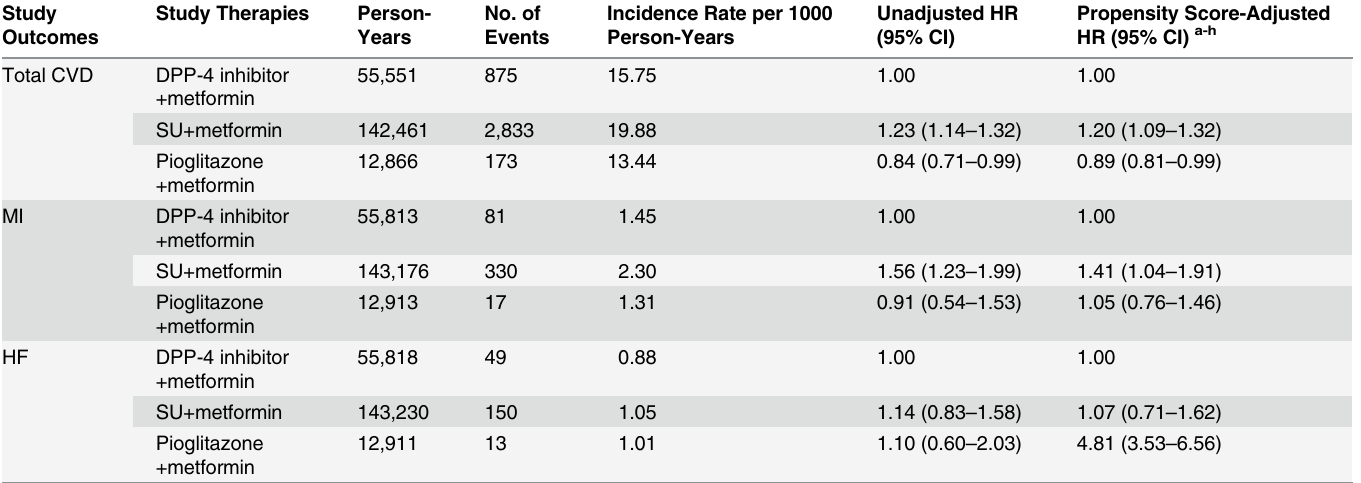
Table 2. Incidence rates and relative risks of total cardiovascular disease, myocardial infarction, heart failure, and ischemic stroke in patients treated with a DPP-4 inhibitor plus metformin vs. sulfonylurea derivative plus metformin and pioglitazone plus metformin. Study Study Outcomes